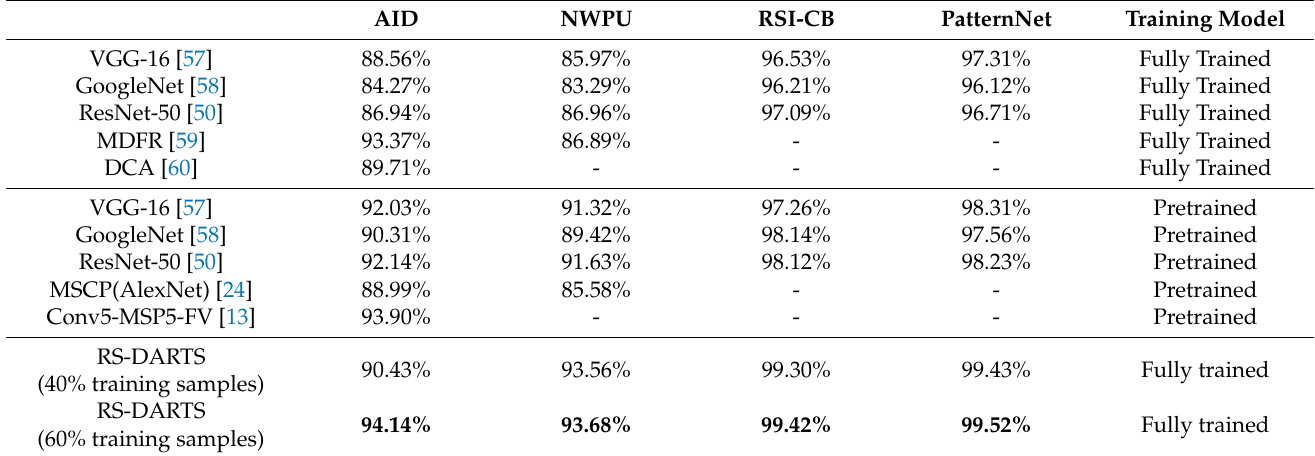
Table 6. The classification accuracy ( OA ) of the classical CNNs model is compared with the final CNN model obtained by